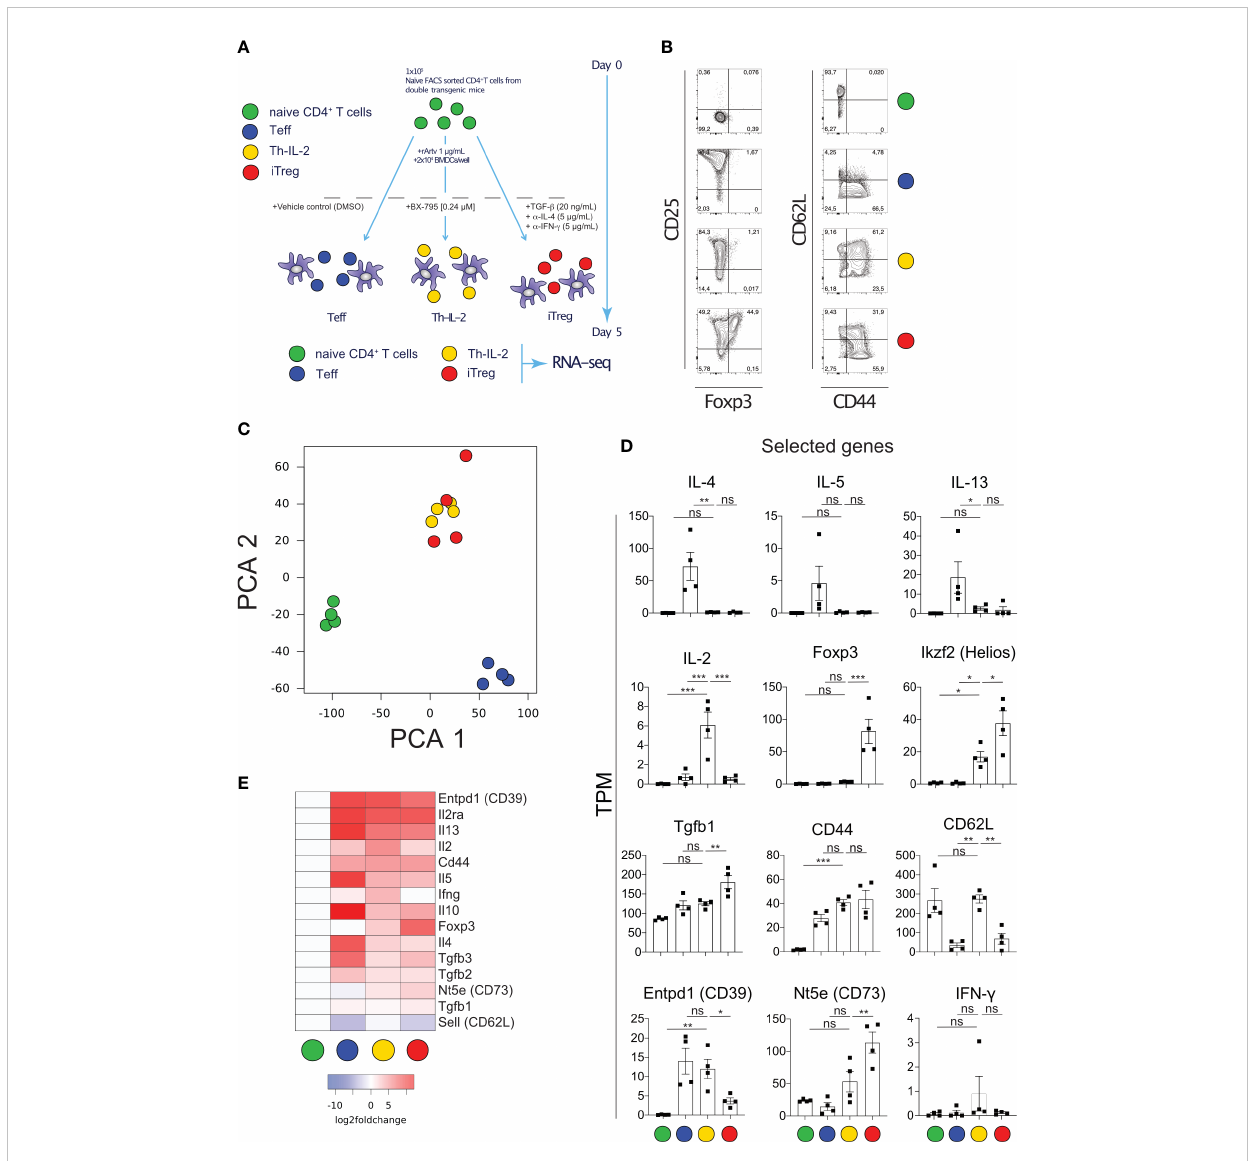
FIGURE 3 Transcriptomic analyses of naïve T cells activated allergen-speci fi cally in the presence of BX-795 reveals a Th-IL-2 cell phenotype which is distinct from but has close similarities with iTregs. (A) , shown is the experimental scheme for allergen-speci fi c T cell activation. For each experimental condition and the numbers of experiments performed a colored dot is assigned. (B) , shown are representative FACS plots of freshly sorted naïve (0 h) and differentially activated (120 h) CD3 + CD4 + T cells upon culture at the conditions shown in (A) . (C) , shown are the results of the principal component analyses (PCA) of the RNA-Seq data derived from viable and naïve (0 h) and differentially activated (120 h) CD3 + CD4 + T cells according to (A) . Colors indicate the respective experimental condition, dots the results of the independently performed experiments. (D) , shown are bar graphs (mean values ± SEM) summarizing the expression of selected genes for the four experimental conditions as transcripts per million (TPM). Data shown are representative for one out of 4 experiments in (B) and show the mean value ± SEM of four independently performed experiments in (D) . In (D) , statistical analysis was performed with one-way ANOVA with Dunnett ’ s correction of multiple comparisons. All comparisons performed against the condition Th-IL-2. (E) , shown is a heat-map displaying the expression of manually curated T helper cell signature genes. Statistically signi fi cant changes are indicated with *, p < 0.05; **, p < 0.01; ***, p < 0.001. ns, non-signi fi